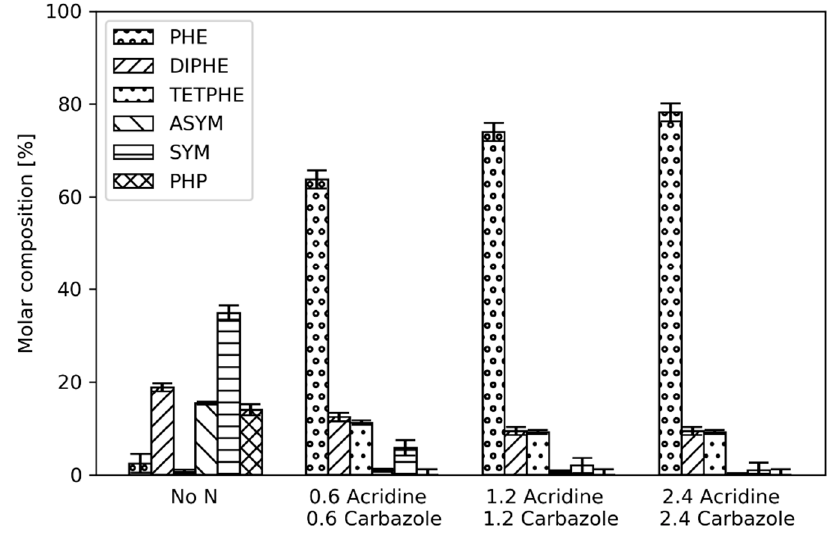
Figure 10. Phenanthrene product distribution from hydrogenation at 300 °C with varying content of carbazole and acridine in the reactant feed. The number next to the nitrogen compound is the concentration in mmol/dm 3 .